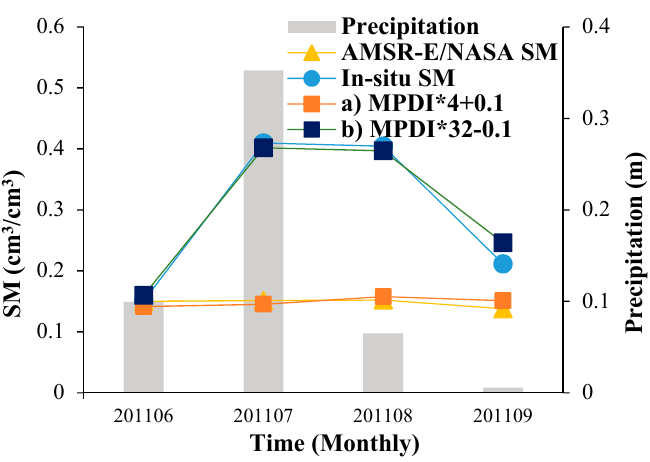
Figure 12. Poland study area SM in 2011, cases a) and b) in Table 1, AMSR-E/NASA SM product and in-situ SM measurements, and precipitation.